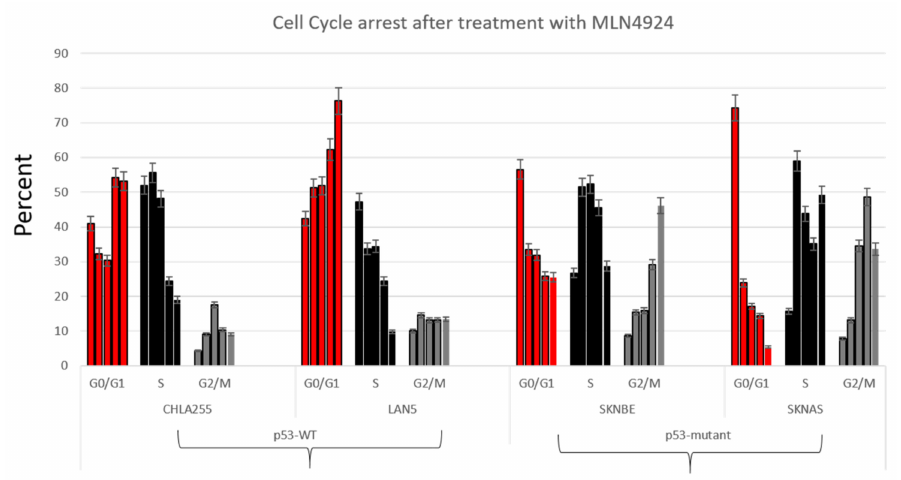
Figure 4. Cell cycle arrest as demonstrated by BrdU staining in neuroblastoma cell lines after treat- ment with pevonedistat. First bar: no treatment, second bar: 16 h MLN4924, third bar: 24 h MLN4924, fourth bar: 48 h MLN4924, fifth bar: 72 h MLN4924. Data is representative of repeat experiments.